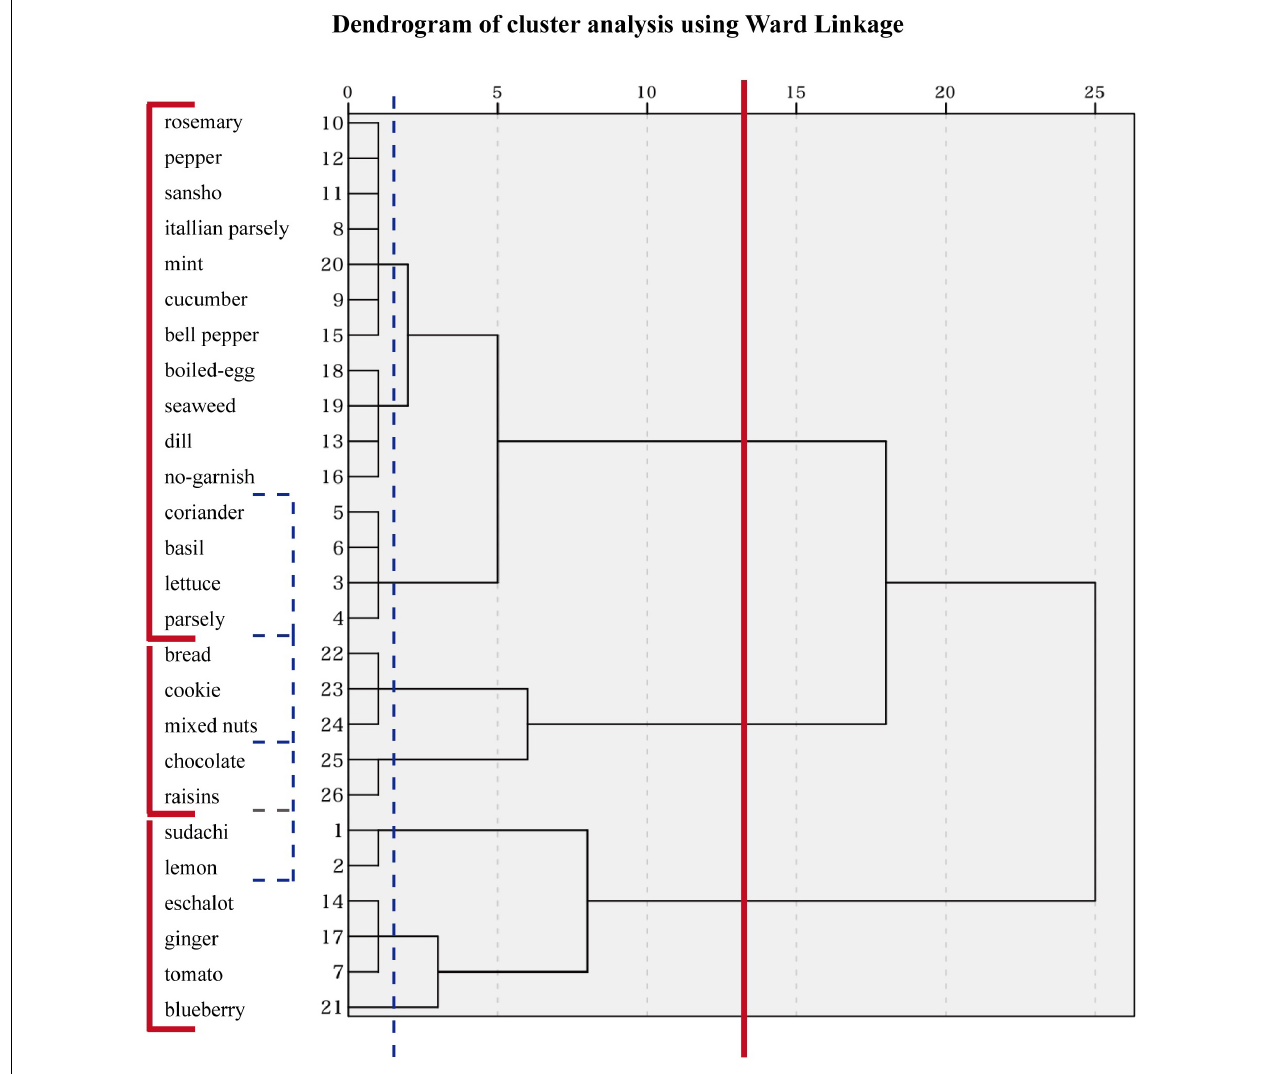
FIGURE 4 | Cluster analysis classified the 26 types of garnish into 3 clusters. The solid line indicates three main clusters, and the dashed line shows more precise clusters in this